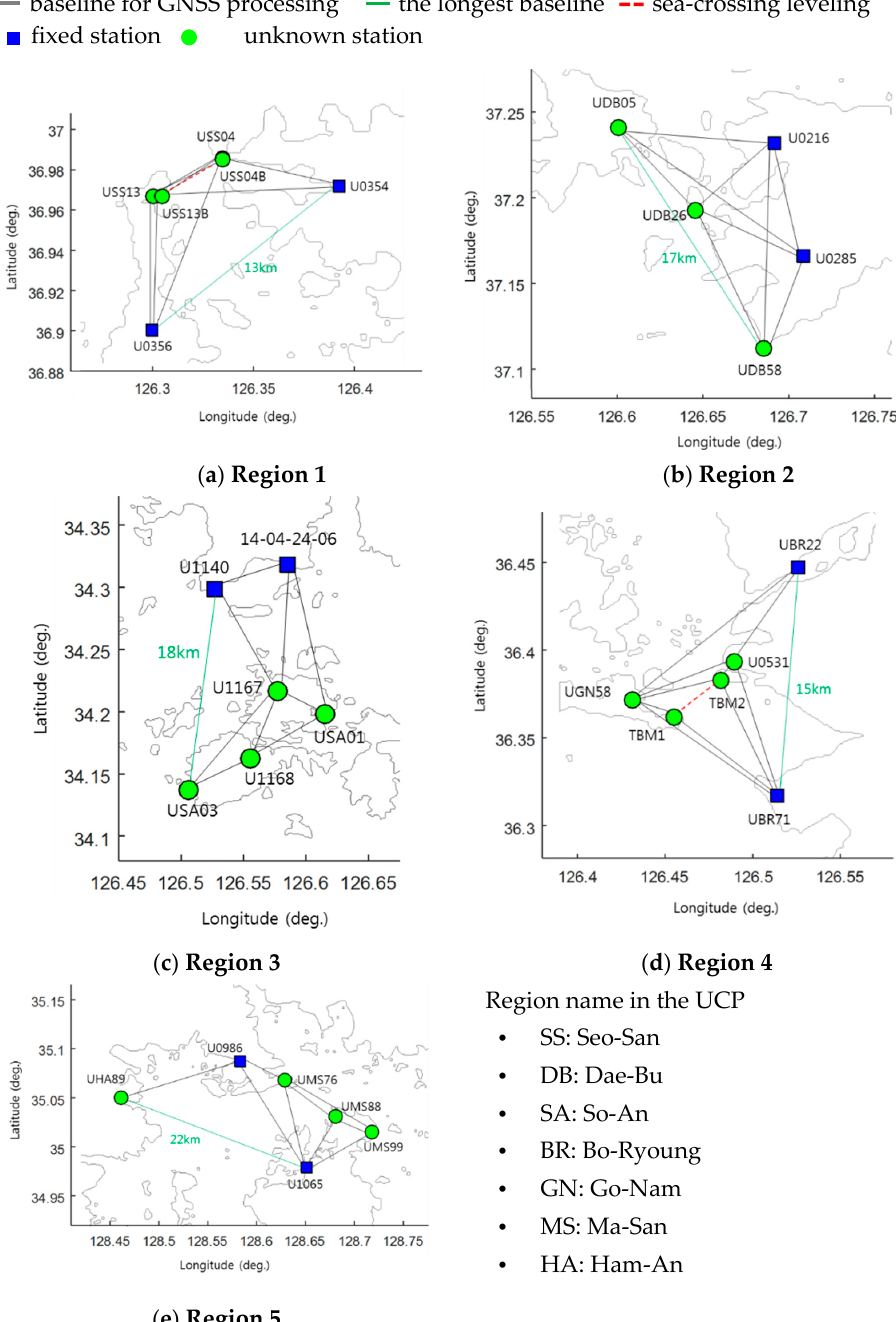
Figure 2. Surveying stations and their distribution in the five test regions.